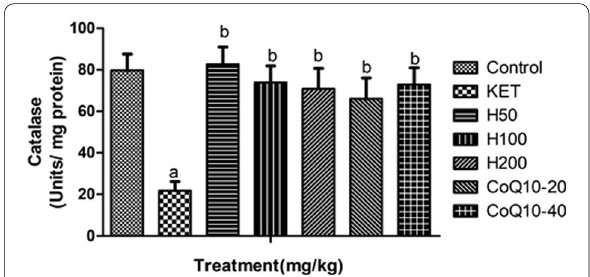
Fig. 9 Effect of hesperidin and Coenzyme Q10 on brain SOD levels in the prefrontal cortex and hippocampus region of the brain. Data were analyzed by one-way ANOVA followed by Tukey’s post hoc analysis. All values were expressed as Mean as compared to naive, b p < 0.05 as compared to ketamine. KET, Ketamine; H, Hesperidin; CoQ10, Coenzyme